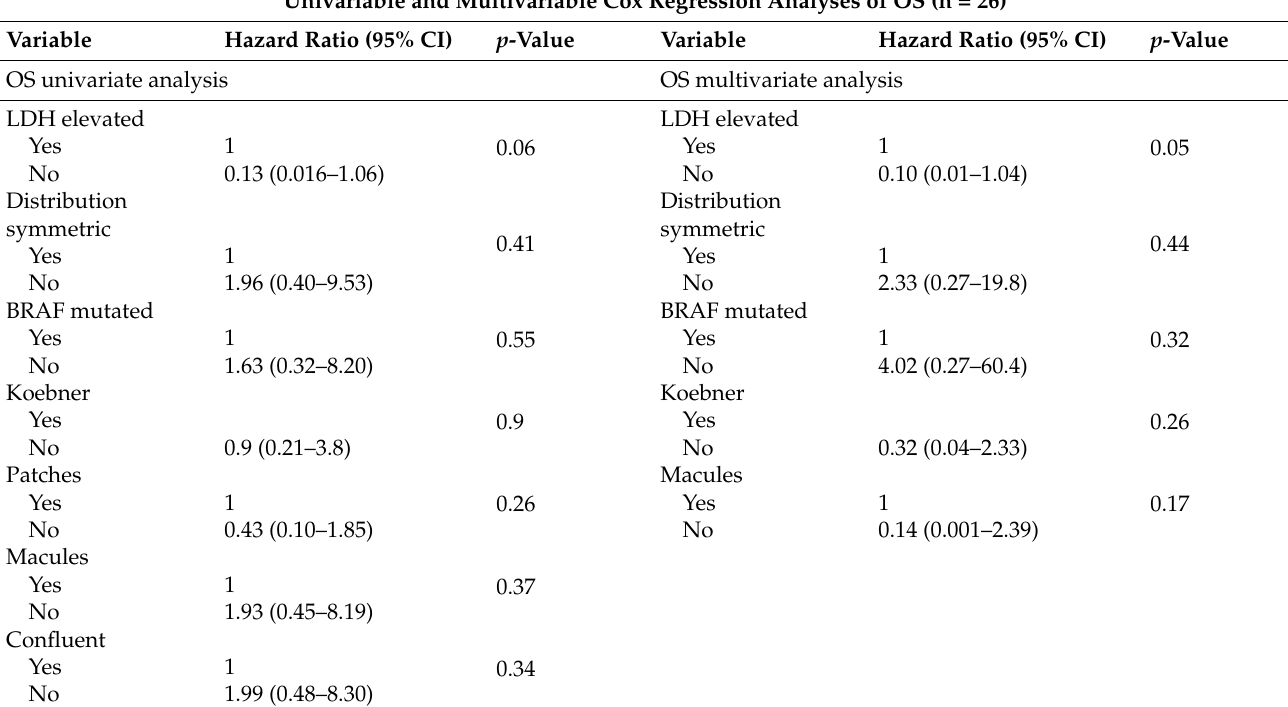
Table 4. Univariable and multivariable Cox regression analyses of the overall survival. Univariable and Multivariable Cox Regression Analyses of OS (n =